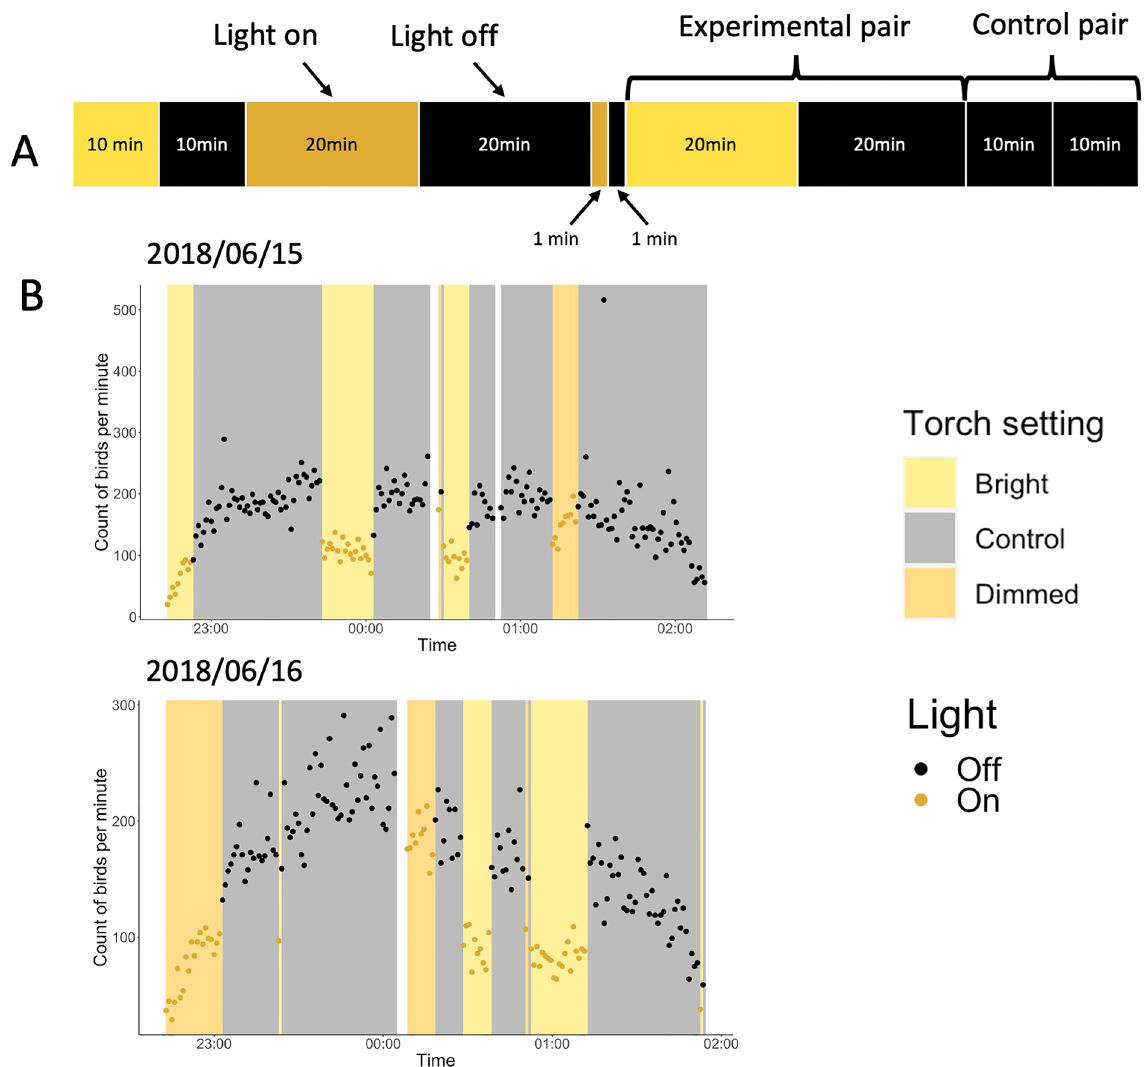
Figure 4. ( A ) Visualisation of treatment series of the interval experiment. Each segment corresponds to the colour (yellow = bright white, orange = dimmed white, black = light off) and duration for which the light was on (or off). In the experimental pairs, we turned the light on and off for different lengths of time (1-, 10- and 20-min intervals). In the control pairs we turned the light off for two consecutive intervals (‘light-off’, ‘light- off’). ( B ) Two example days, 15th and 16th June 2018, of the interval experiment. The graphs show the count of birds per minute against time. Different colour bars represent different settings (bright white, dimmed white and control) and the two dot colours represent light on (yellow) and off (black). White bars represent breaks in the experiment caused mainly by switching to a new recording or by technical